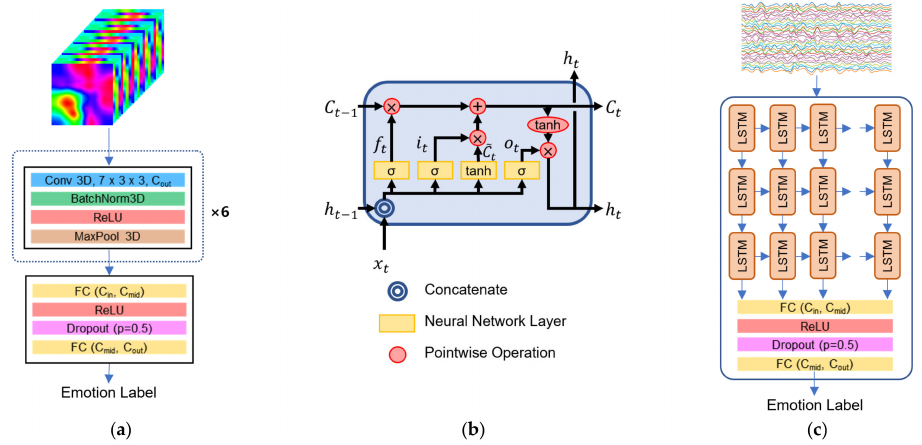
Figure 5. ( a ) 3D CNN architecture without a channel bottleneck; ( b ) Long Short-Term Memory (LSTM) cell architecture; ( c ) LSTM model architecture. Conv, BatchNorm, MaxPool, and FC represent the convolution, batch normalization, max pooling, and fully connected layer, respectively. C in and C out are the input and output channels at each layer, respectively. C mid is the reduced channel by the first fully connected layer. ReLU represents the rectified linear unit activation